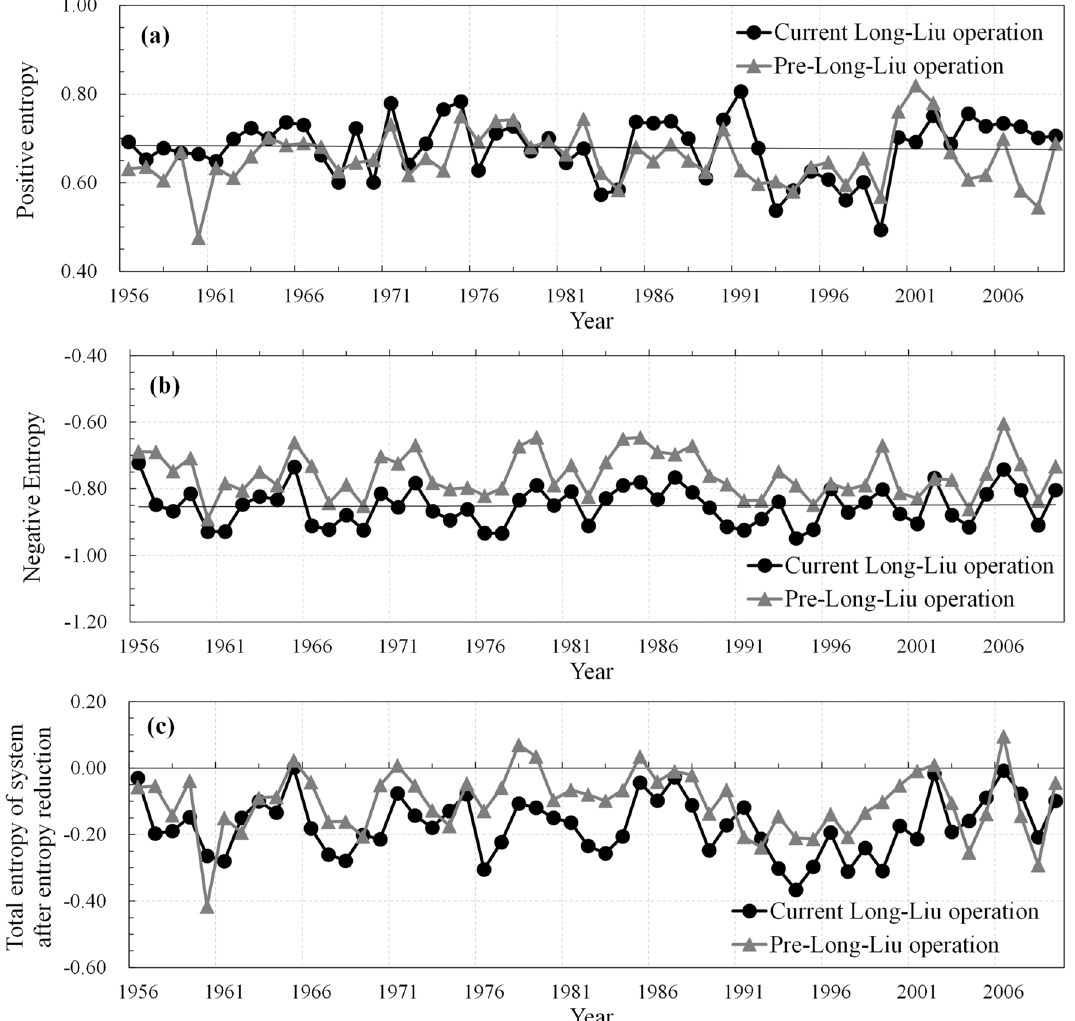
Figure 3. Comparison of the positive, negative and total entropy levels in the current situation and pre-Long- Liu operation state at the inter-annual